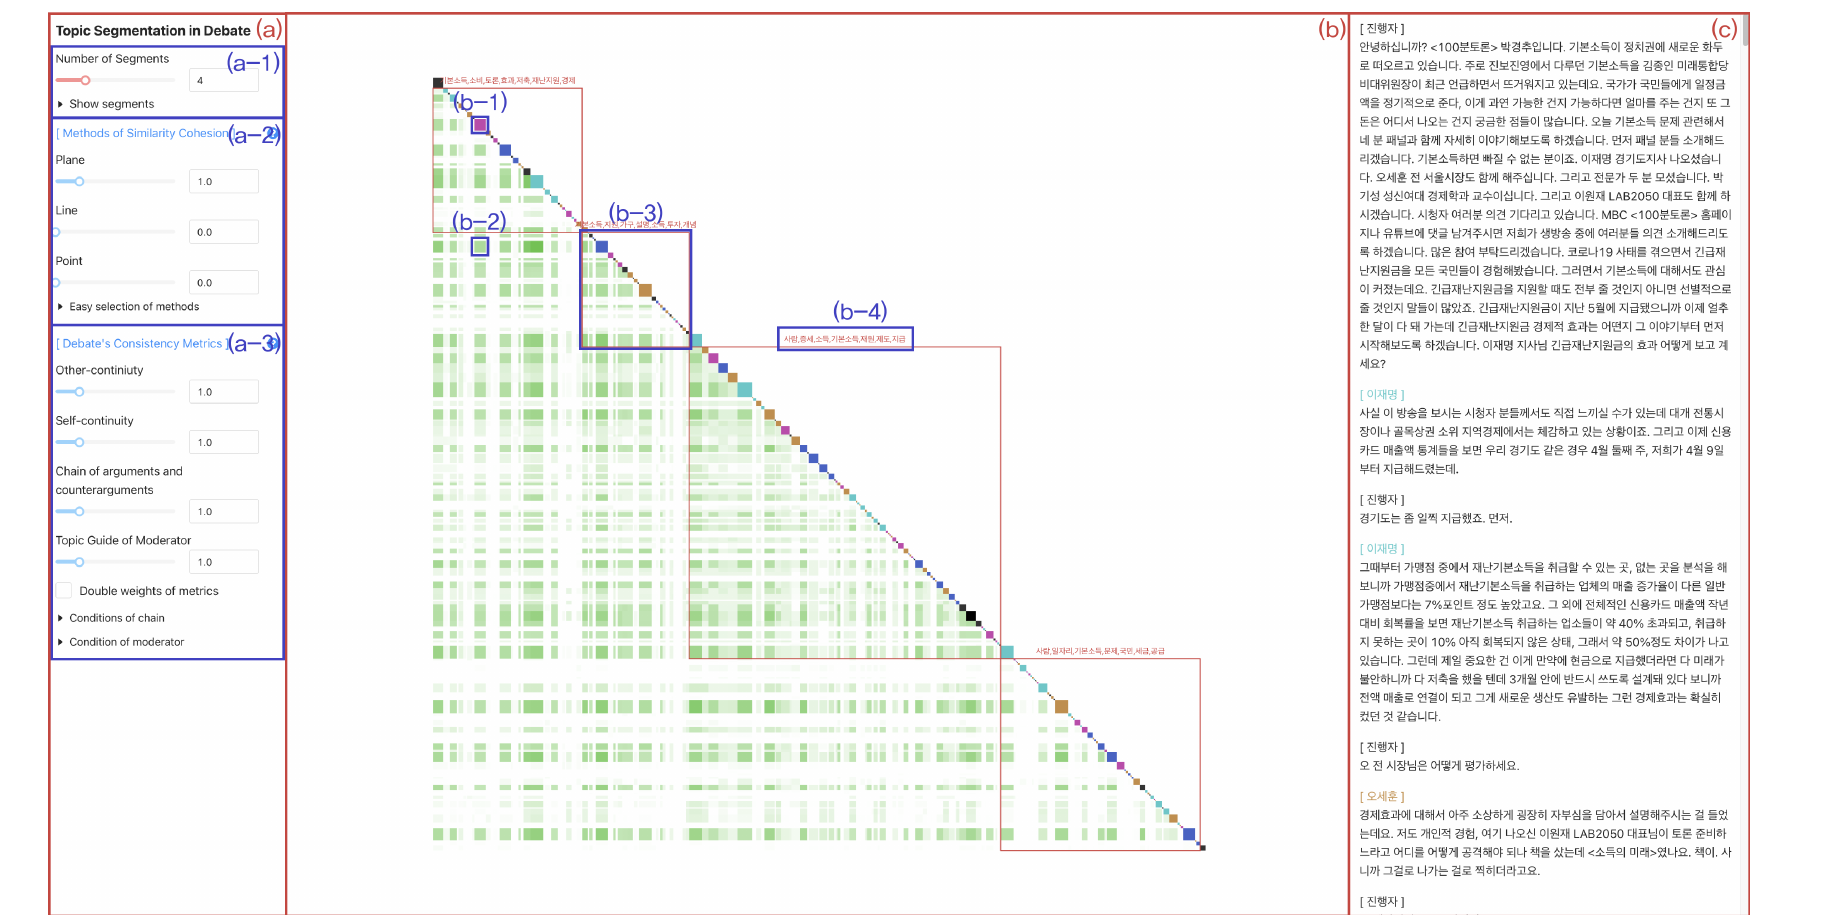
Figure 17. User interface of CSseg: ( a ) is a controller with functions affecting topic segmentation; ( b ) is a visualization of conceptual recurrence showing all utterances, conceptual similarities, and topic segments; ( c ) is a transcript viewer that shows the content of the debate participants’